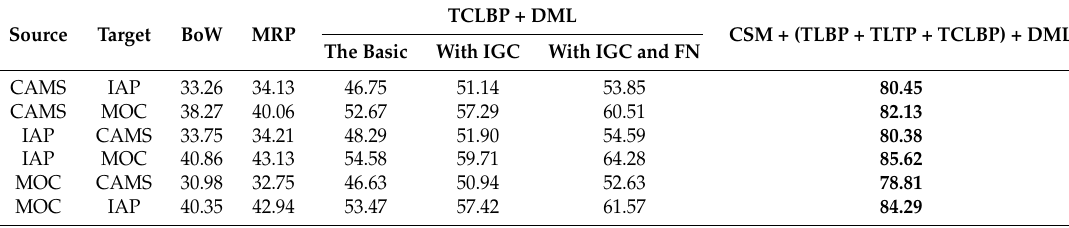
Table 8. Cross-domain classification accuracies (%) comparing our method with state-of-the-art methods.